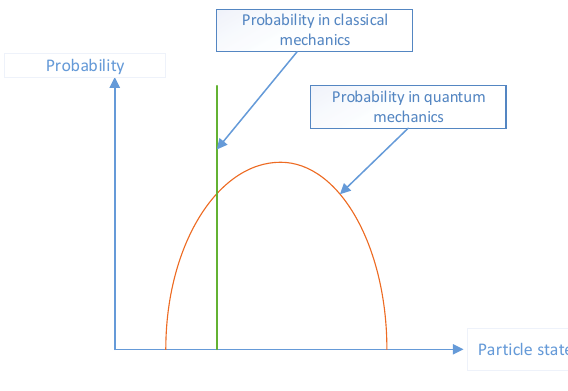
Figure 3. Particle state and